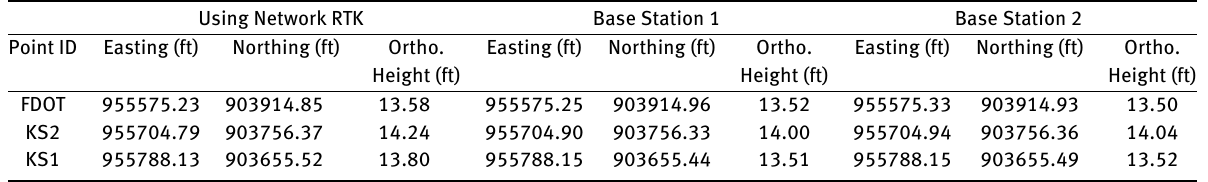
Table 2: Coordinates obtained using different reference stations.